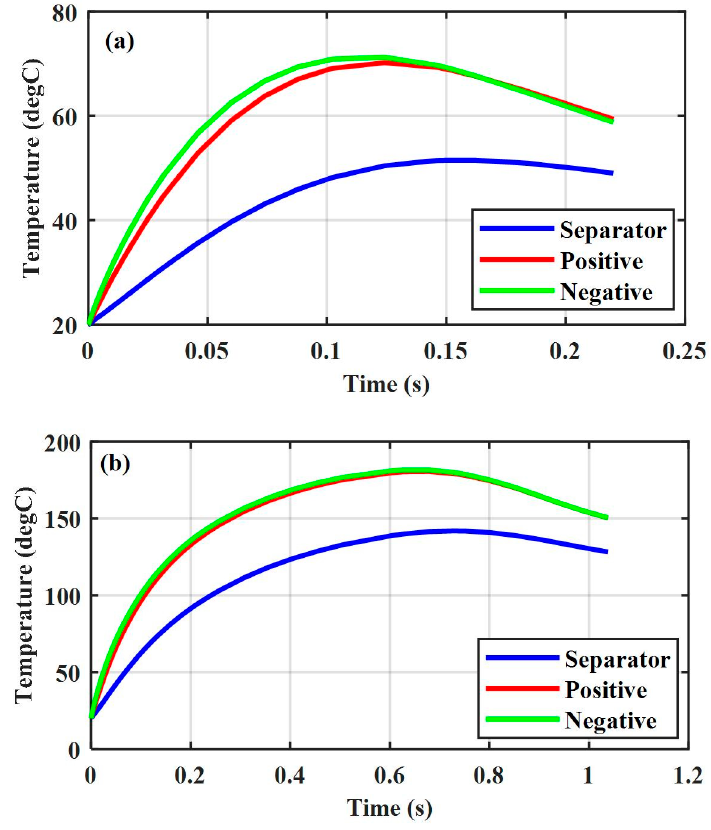
r , positive–negative ( a ) SOC = 0.2, and ( b ) in